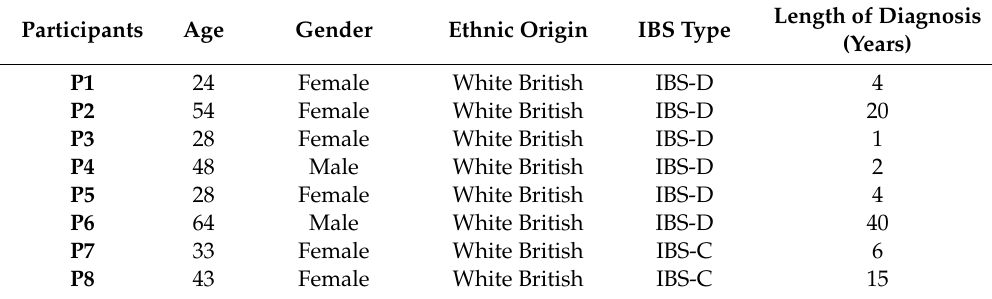
Table 2. Characteristics of participants.